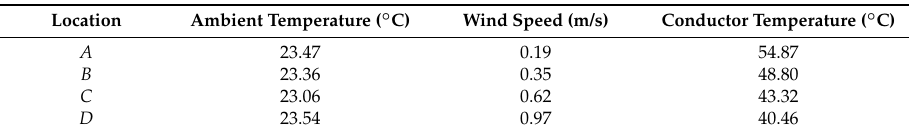
Table 2. Conductor temperatures at different